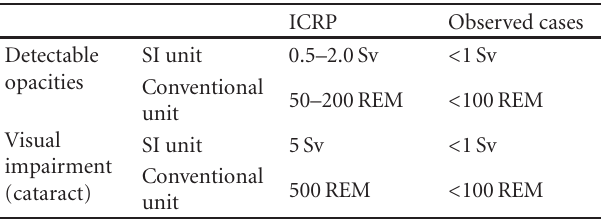
Table 2: ICRP threshold dose values compared to observed opaci- ties and cataracts [5,